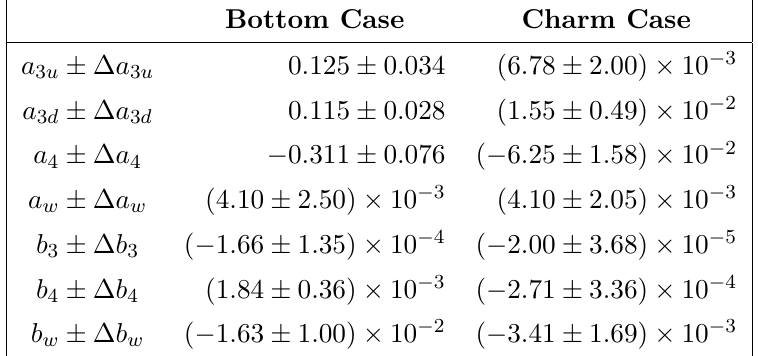
Table 1 . Numerical values for the coefficients a and b and their respective uncertainties as defined in eq.